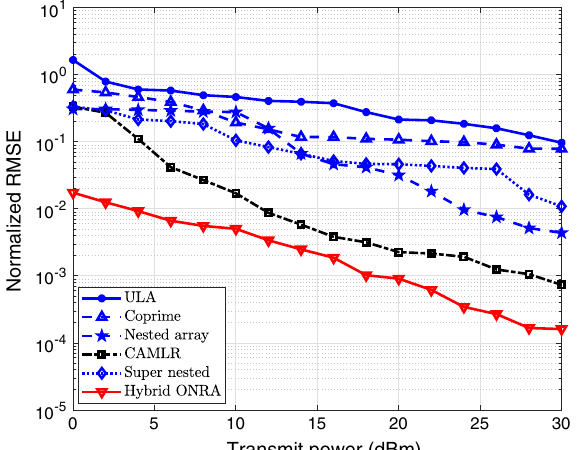
Fig. 7 RMSE of the CU-RIS channel versus different transmit power of